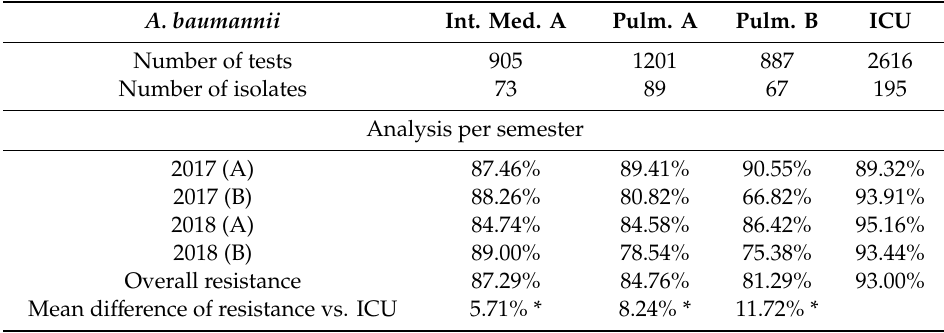
Table A4. Number of tests processed in di ff erent antibiotics, number of isolates collected, overall resistance per ward and semester and mean di ff erence of resistance versus ICUs regarding A. baumannii during the 2 years (2017–2018).